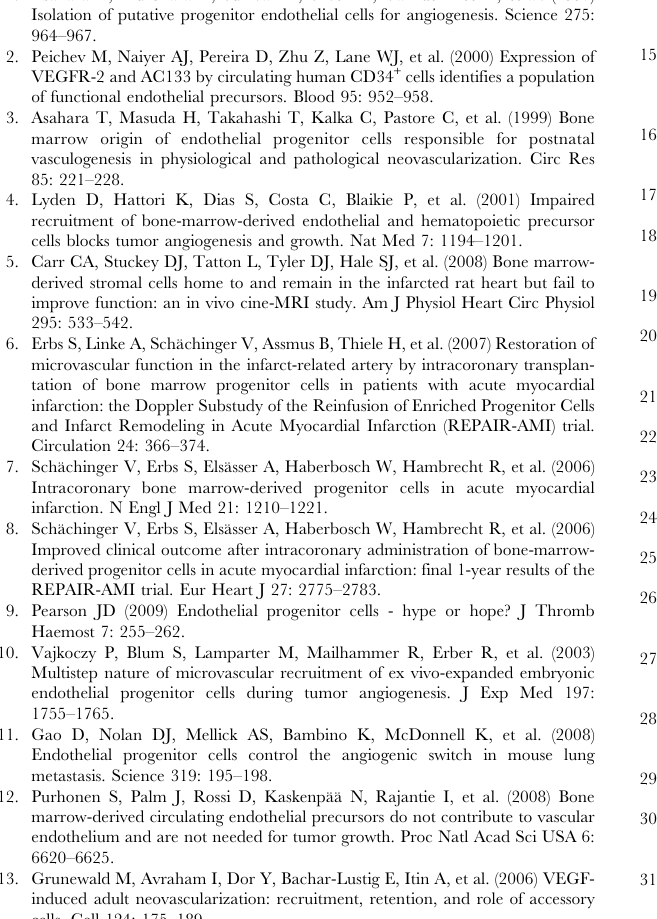
Note the presence of QH1 + HC at the aortic luminal surface (G, orange dots). Bar: 30 mm in G and I, 10 mm in H. (TIF) Figure S3 Half embryo chimeras. A) This cross section illustrates the junction region between quail and chick territories where quail (QNT) and chick (CNT) neural tubes overlap. In the quail region QH1 + vessels are present. In the chick territory, a part of the neural tube is vascularized by quail EC that have migrated interstitially. The QH1 + dots on the left are quail HC. B) Section of the quail allantois vascularized by QH1 + vessels. C) QH1 + vessels present in the quail wing bud. D) Section of the chick yolk sac with QH1 2 vessels in which QH1 + HC (arrows) are observed. E) Presence of a quail QH1 + /BEN + HC (arrow) in the rhombencephalic mesenchyme together with a chick QH1 2 / BEN + HC (arrowhead), probably a macrophage. Note that BEN stains the neuronal plexus (*) in the epithelium (E). F) LEP100 + macrophages detection in the diencephalic mesenchyme. One double stained QH1 + / LEP 100 + quail macrophage (arrow) is seen among chick ones (arrowheads). Bar: 40 mm in A–F.